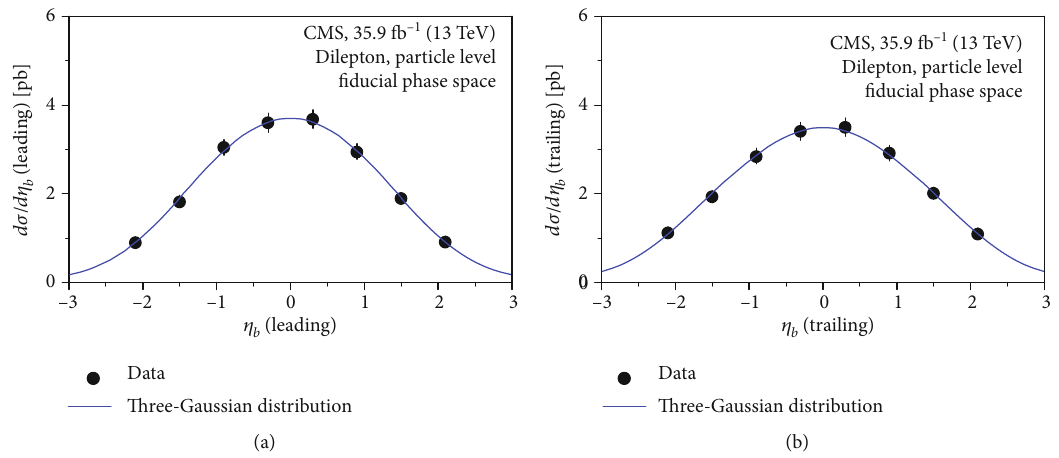
η T ( b (leading)) and (b)